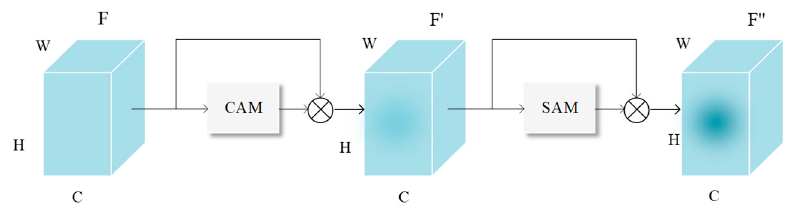
Figure 2. CBAM module structure.